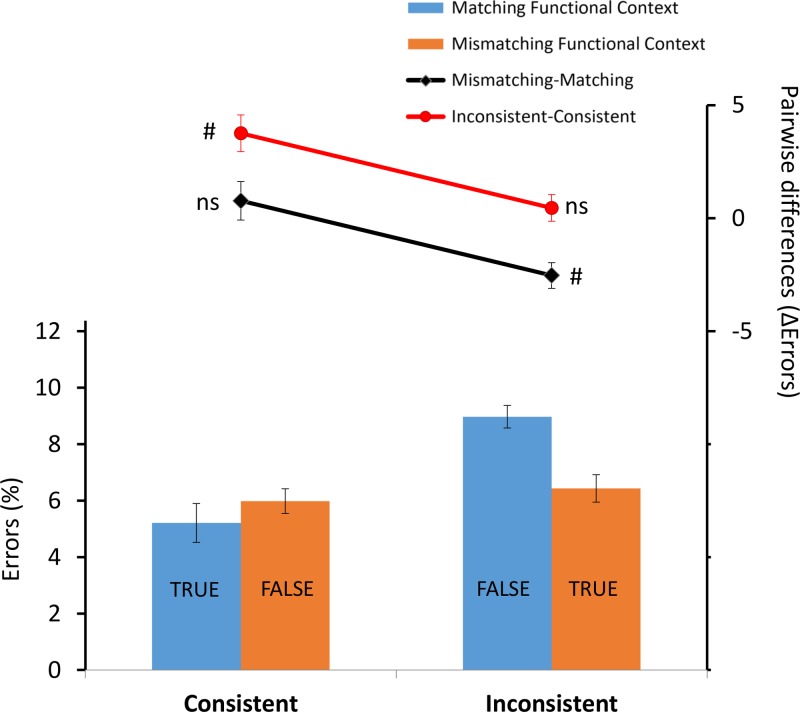
The bar plot shows the mean of percentage of error rates as a function of X (consistent vs. inconsistent) and Y (matching functional context vs. mismatching functional context) factors. Error bars indicate within-subjects SEM (Morey, 2008). The black and red line plots show, respectively, the functional context effect (i.e., the mismatching functional context – matching functional context pairwise difference) in consistent and inconsistent conditions and the consistency effect (i.e., the inconsistent–consistent pairwise difference) in matching functional context and mismatching functional context conditions. The corresponding error bars indicate the SEM of the pairwise differences (Franz and Loftus, 2012). (#) indicates consistency and functional context effects that were significantly (p < 0.05) different from 0; (ns) indicates non-significant effects. TRUE and FALSE represent the two response options.